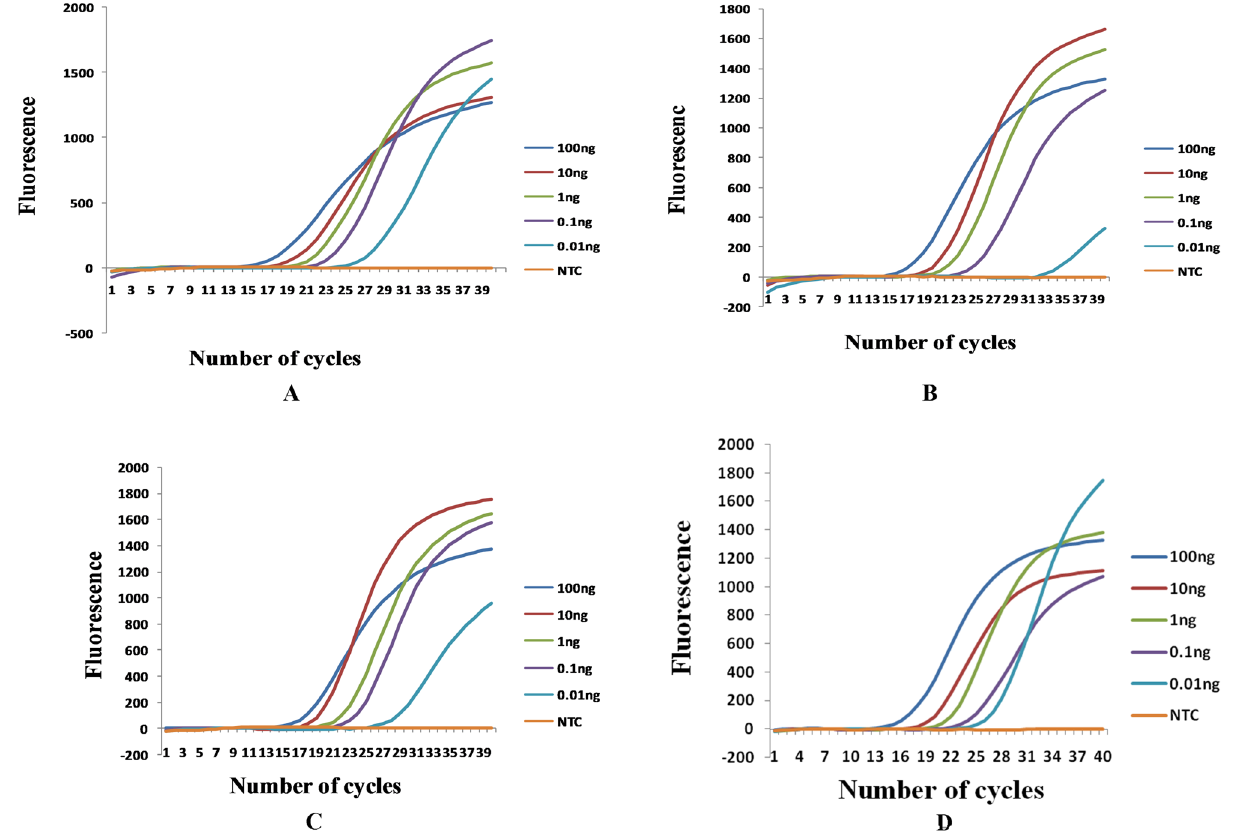
Figure 3. Standard curve for absolute quantification of genomic DNA generated with tenfold serial dilutions of genomic DNA isolated from infected plant material of probable R. solani AG-1 IA infection using RSPG primer sets. The curves show the relative fluorescence intensity with respect to the number of PCR cycles. ( A ) RSPG 1 primer set, ( B ) RSPG 2 primer set, ( C ) RSPG 4 primer set, and ( D ) RSPG 5 primer